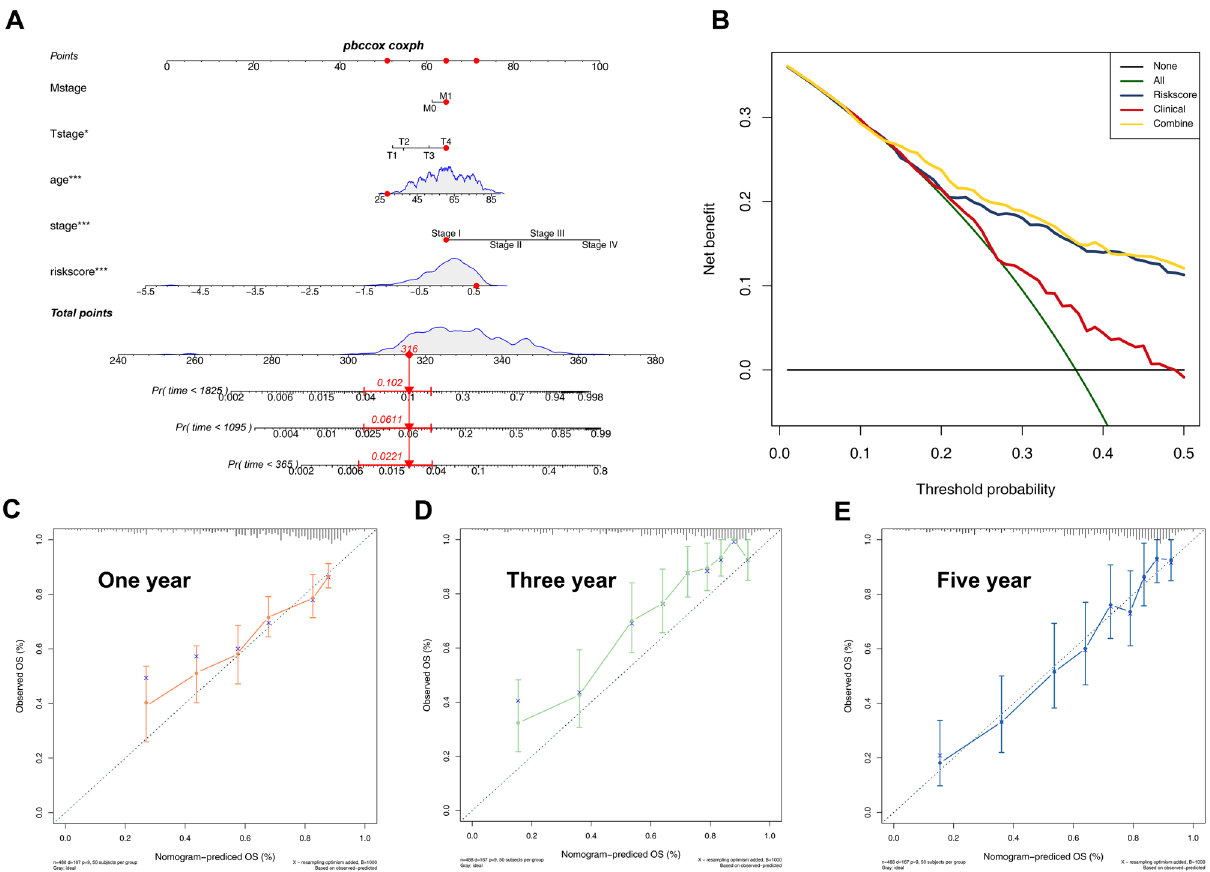
Figure 4. Decision Curves Analysis (DCA) of clinical model and risk signature. Notes: ( A ) Nomogram of clinical parameters-based prediction model for prognosis of patients. ( B ) Decision curves for different predicting models. Horizontal line: assume all patients as low risk (Pi < Pr); Green curve: assume all patients as high risk (Pi > Pr); Red curve: clinical prediction model; blue curve: gene signature; Yellow curve: combination use of two models. Calibration curves for nomogram in predicting survival probability at 1 year, 3 years and 5 years. The calibration measurement was conducted through bootstrapping 1000 resamples in TCGA-KIRC database ( C-E